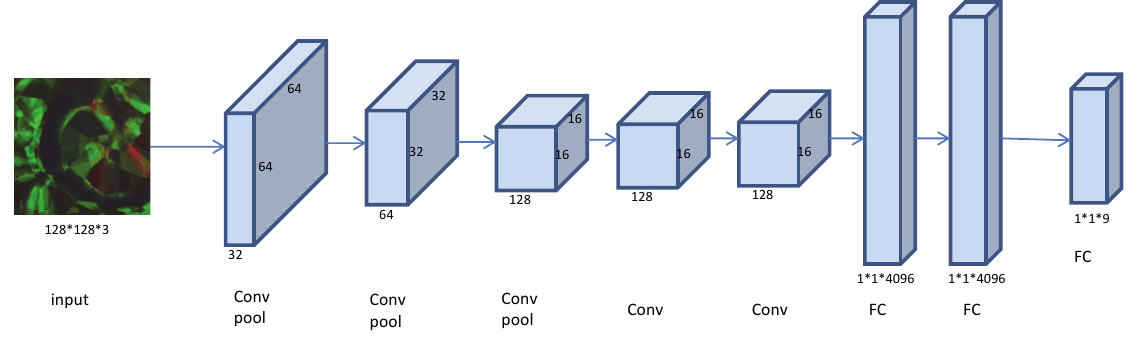
Figure 1. The architecture of the used deep CNN